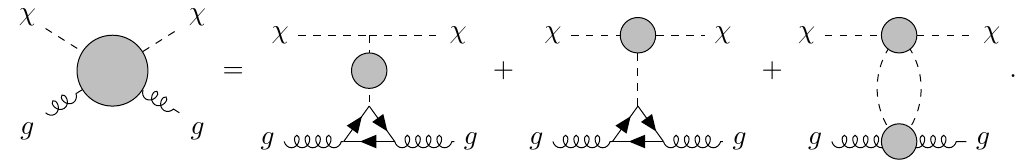
Figure 8 . Generic one-loop correction of the DM-gluon interaction. The contributions can be split in mediator, vertex corrections and the effective two-loop contributions. The gray blob indicates the genuine one-loop corrections and the respective counterterm insertion. Figure 9 shows the details of the contribution of each of the blobs of the last